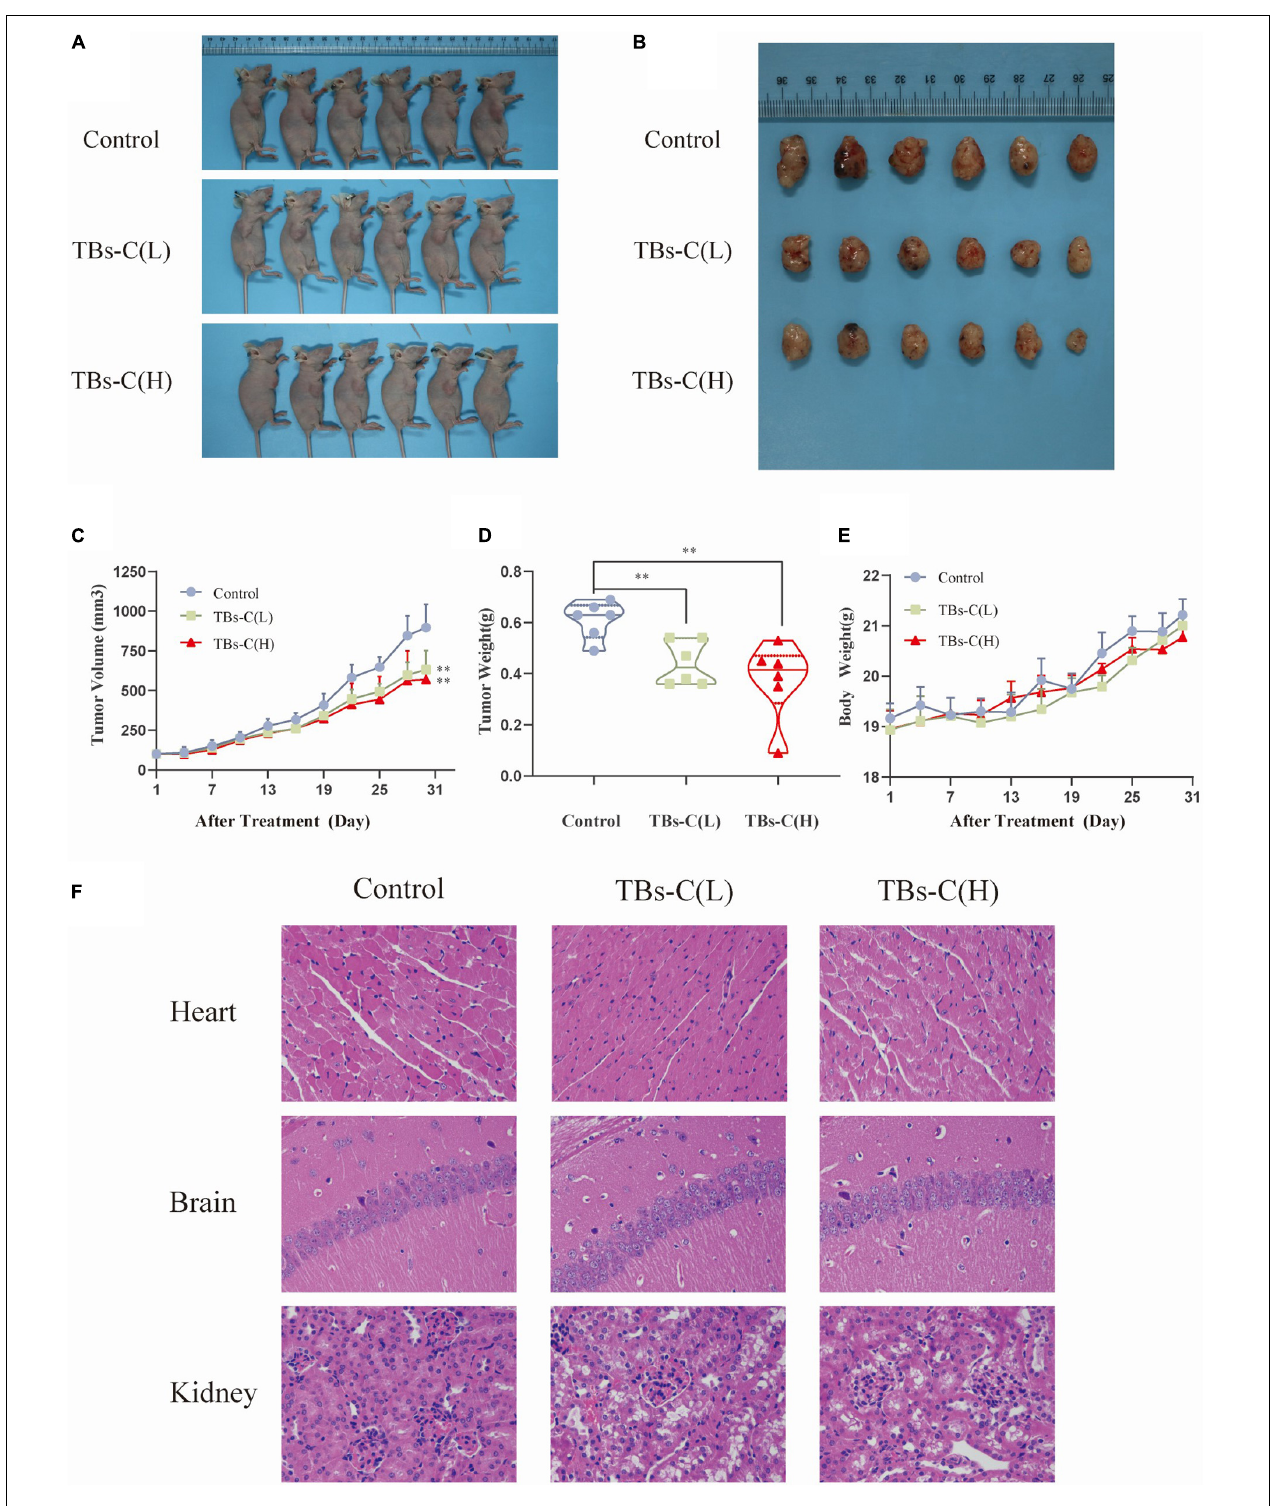
FIGURE 8 | TBs-C inhibits the growth of A549 xenograft tumors in vivo . (A) Tumorigenesis of A549 cells of the 3 study groups on day 28. (B) Representative size of the 3 groups of tumors. (C) Tumor volumes (measured every 3 days). (D) Tumor weight in the control group, low-dose group, and high-dose group. (E) The weight of nude mice was recorded every 3 days. (F) H&E stained the heart, brain, and kidney of mice from each group. TBs-C (L), TBs-C low-dose group, TBs-C (H), TBs-C high-dose group, * p < 0.05, ** p < 0.01.